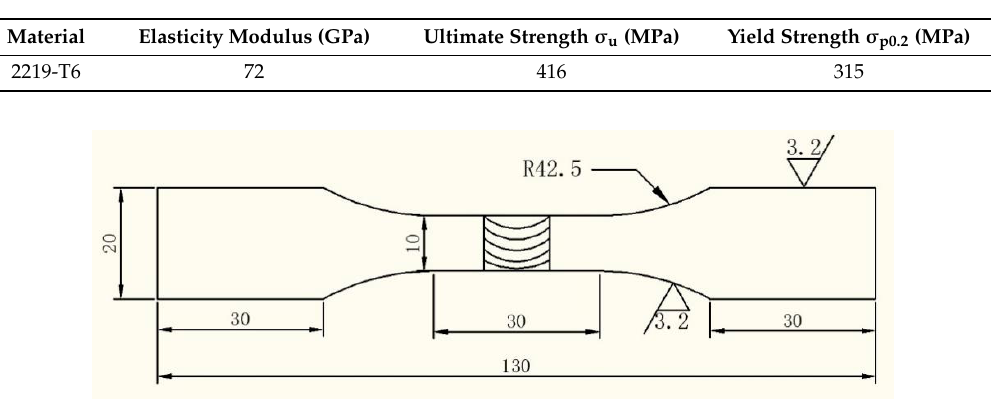
Table 2. Mechanical properties of 2219-T6 aluminum alloy.